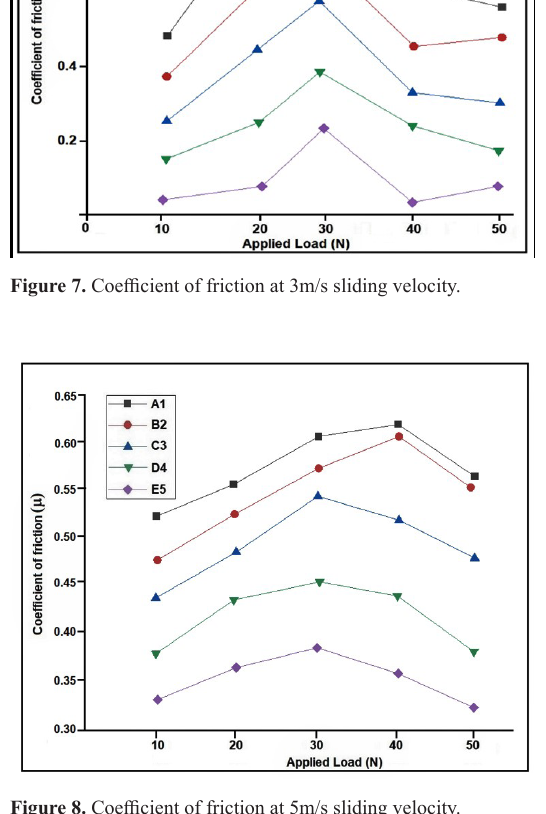
Figure 8. Coefficient of friction at 5m/s sliding